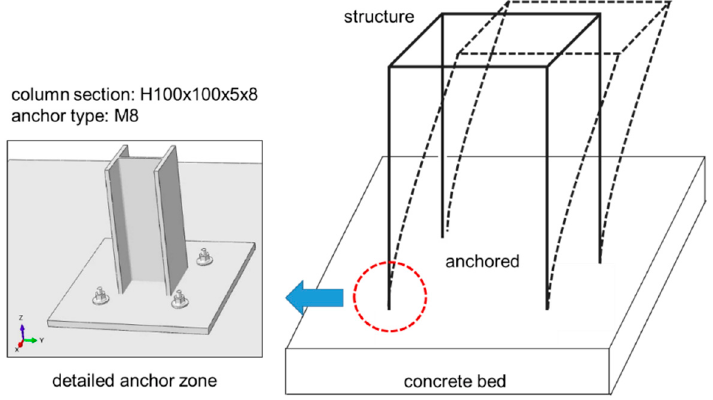
Figure 4. Anchor zone modeling for the pushover test.